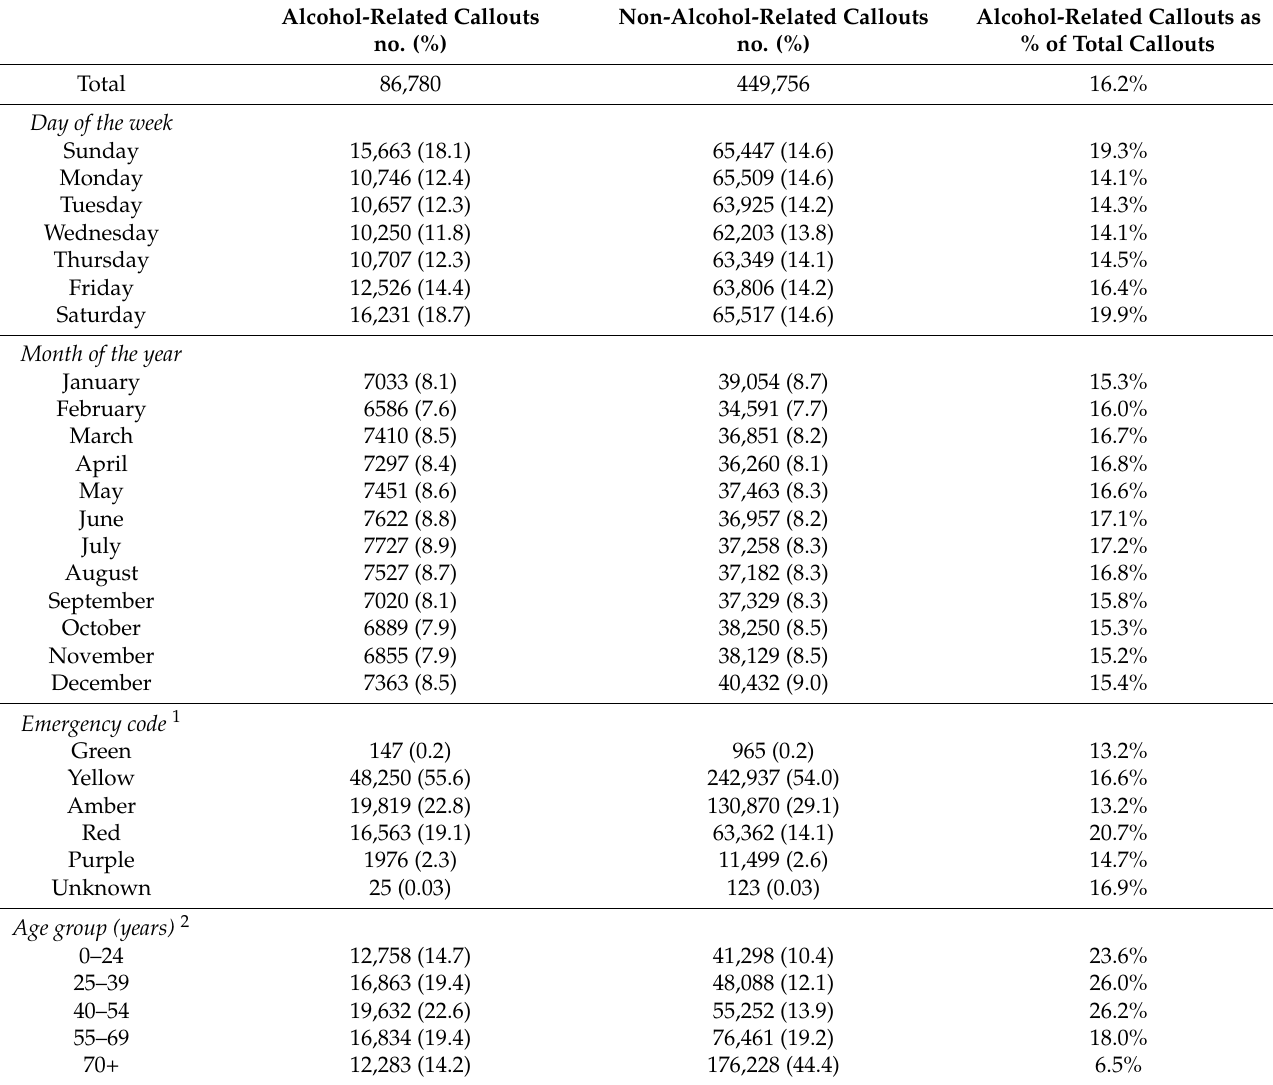
Table 3. Descriptive statistics regarding alcohol-related and non-alcohol-related ambulance callouts in